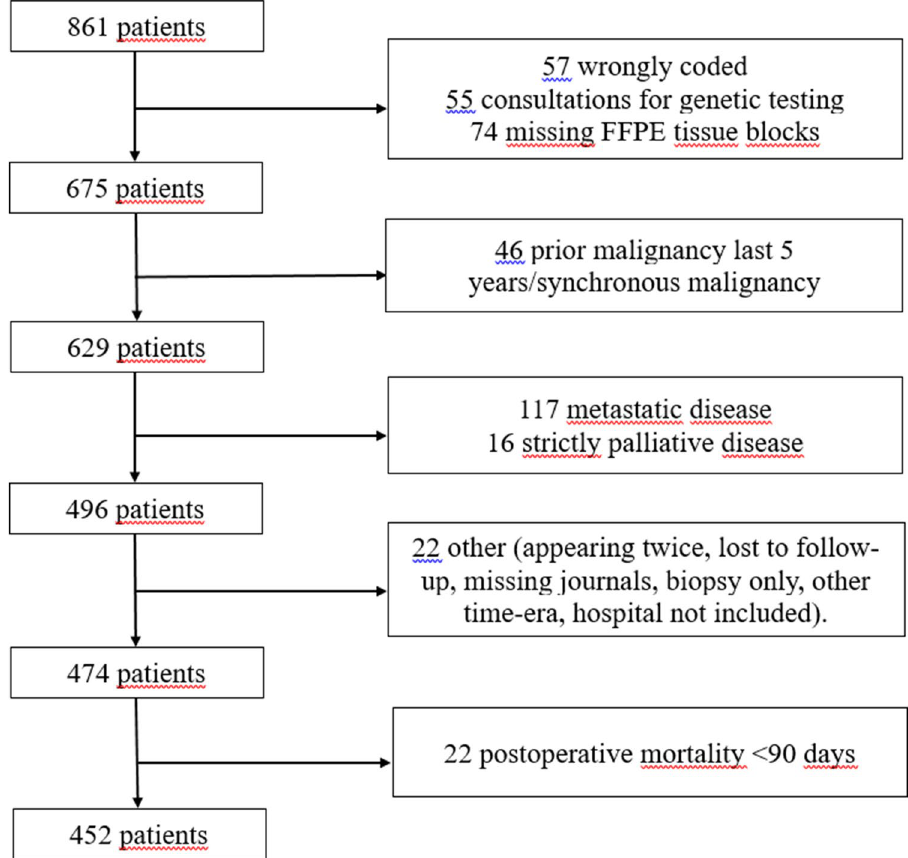
Figure 3. Flowchart of the inclusion of patients in the